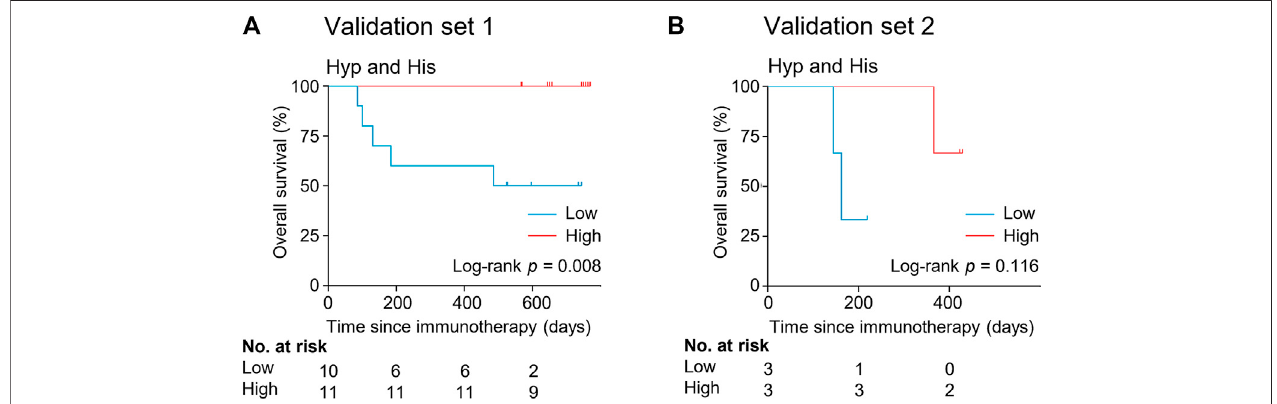
FIGURE6| Kaplan-Meier estimates ofoverallsurvivalbyserum levels ofhypoxanthineand histidineinthevalidationset1 (A) andvalidationset2 (B) .His,histidine; Hyp, hypoxanthine.